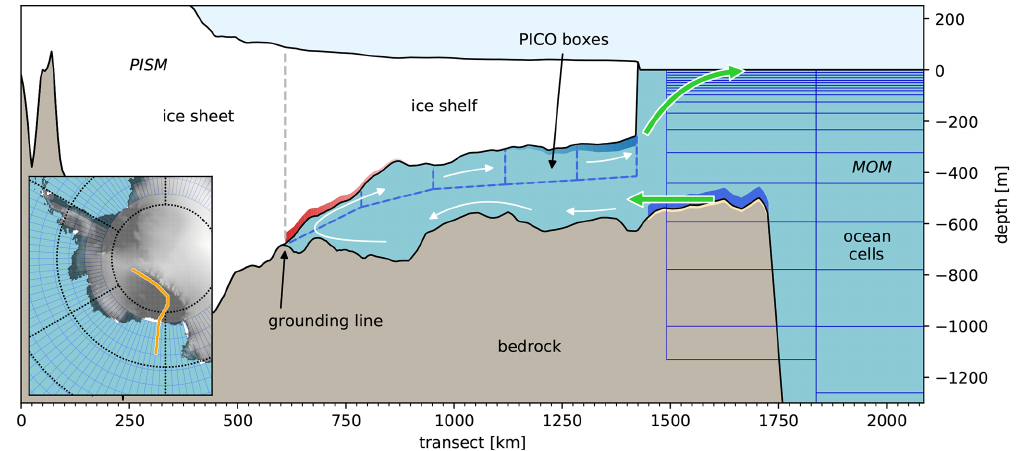
Figure 3. Coupling framework for the PISM ice sheet component and the MOM5 ocean component via the PICO ice shelf cavity model. A cross section of PISM bedrock (brown) and ice thickness (white) is compared to the MOM5 ocean cells (blue continuous lines). The inset shows the transect line (in orange) in the Antarctic region. PICO boxes (blue dashed lines) follow the overturning circulation in the ice shelf cavity. The circulation is indicated by white arrows with the highest melting in the deepest regions close to the grounding line (red shading) and lower melting or refreezing in the shallower areas towards the ice shelf front (blue shading). The exchange of variables and fluxes between the two components is indicated by green arrows: PICO input from MOM5 is taken at the depth of the continental shelf (dark blue regions). Mass and energy fluxes from PICO are transferred to MOM5 through the surface runoff